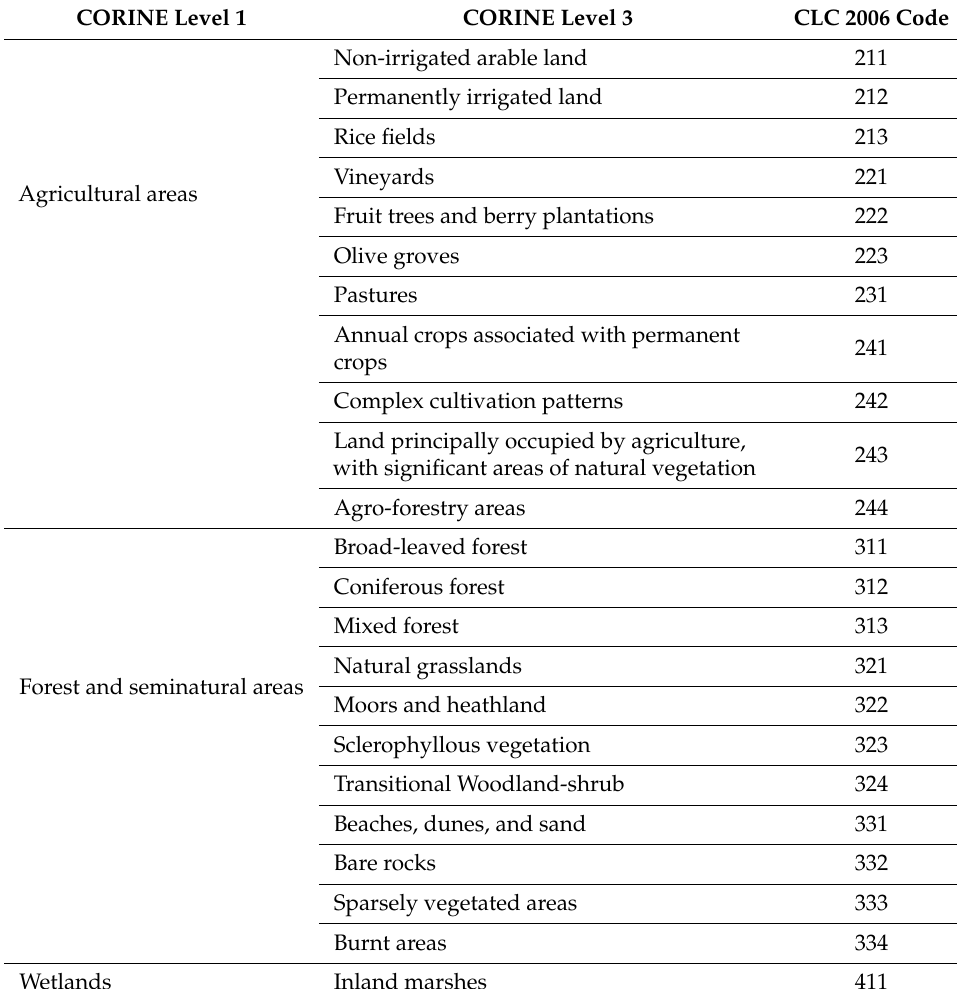
Table 1. Codes of Co-Ordination of Information on the Environment (CORINE) Land Cover (CLC) 2006 classes: levels 1 and 3 of